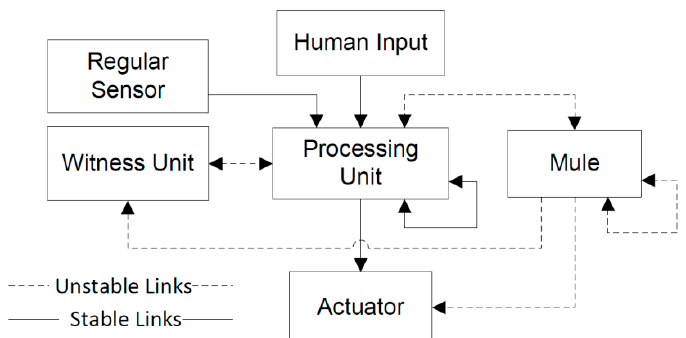
Figure 5. Expected quality links according the node